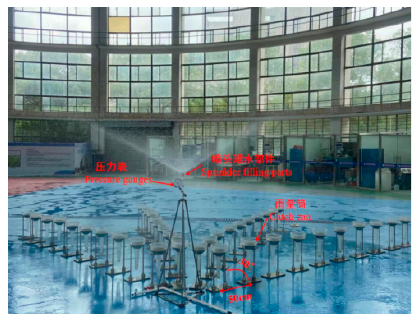
Figure 4. Layout of irrigation water performance.